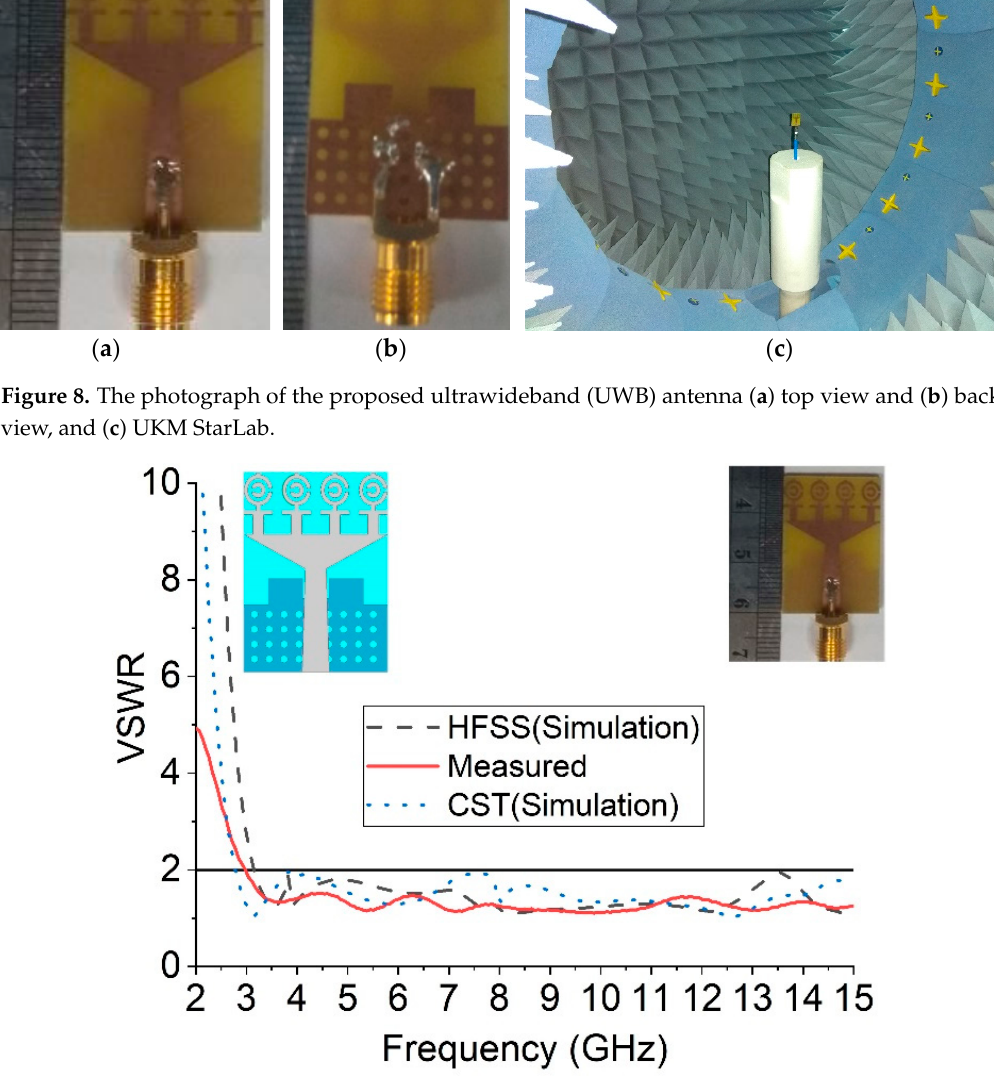
Figure 9. Measured and simulated VSWR curves.